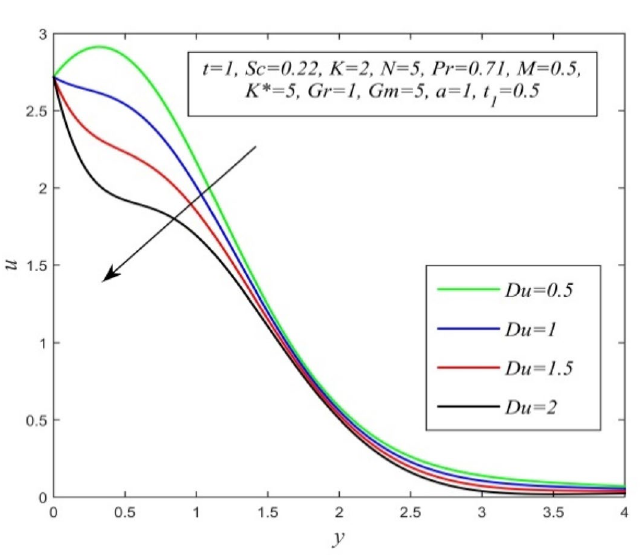
Figure 12. u versus y for different Du and t = 1, Sc = 0.22, K = 2, N = 5, Pr = 0.71, M = 0.5, K* = 1, Gr = 1, Gm = 5, a = 1, t 1 =